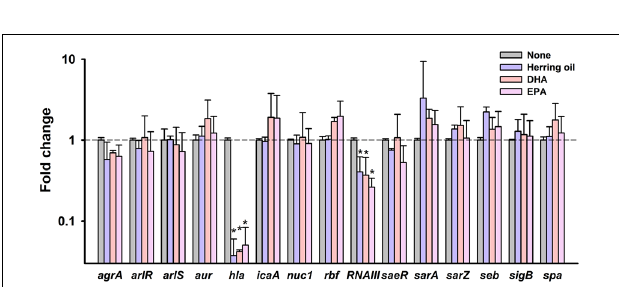
FIGURE 6 | Transcriptional profile changes in S. aureus after treatment with herring oil, DHA, or EPA. S. aureus MSSA 6538 was incubated in LB broth containing herring oil (100 µ g/ml), DHA, or EPA (20 µ g/ml) for 5 h with agitation at 250 rpm. Relative transcriptional profiles were determined by qRT-PCR with respect to 16s rRNA expression. qRT-PCR was performed in duplicate and fold-changes were calculated using treated versus untreated S. aureus . ∗ p < 0.05 vs. non-treated